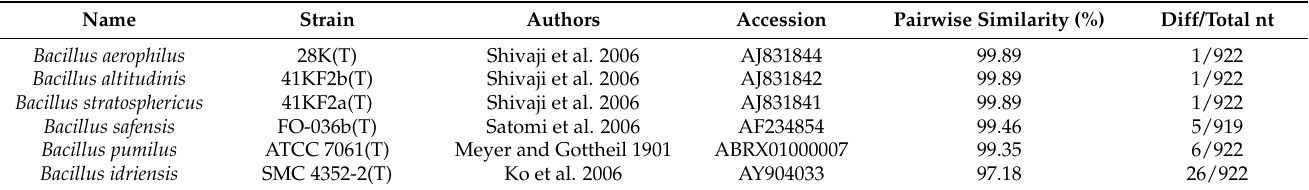
Table 6. Phylogenetic identification of closely related bacteria to the studied strain (922 nt) Bacillus sp.